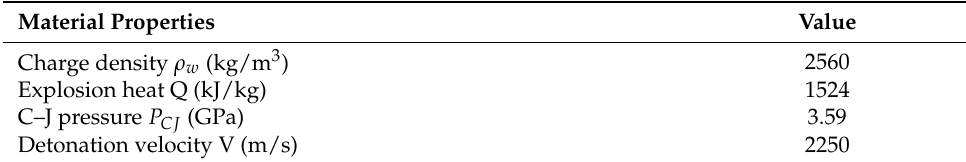
Table 5. PbN 3 main